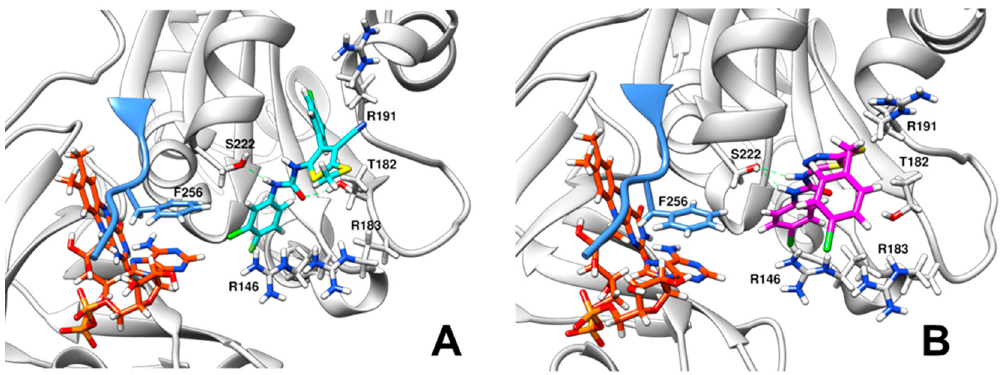
Figure 5. Stabilization of inhibitors in the docking binding cavities. ( A ) Detail of the C12 binding site for the best docking pose of Xcc FPR:C12 after 60 ps of MD simulation. ( B ) Detail of the D5 binding site for the best docking pose of Xcc FPR:D5 after 100 ps of MD simulation. FAD, C12 and D5 are shown in Corey-Pauling - Koltun (CPK) colored sticks with carbons in orange, light blue and pink respectively. The C-terminal extension of Xcc FPR is colored in blue. Side chains of docking relevant residues are highlighted as sticks. Predicted H-bonds are indicated as dashed green lines.